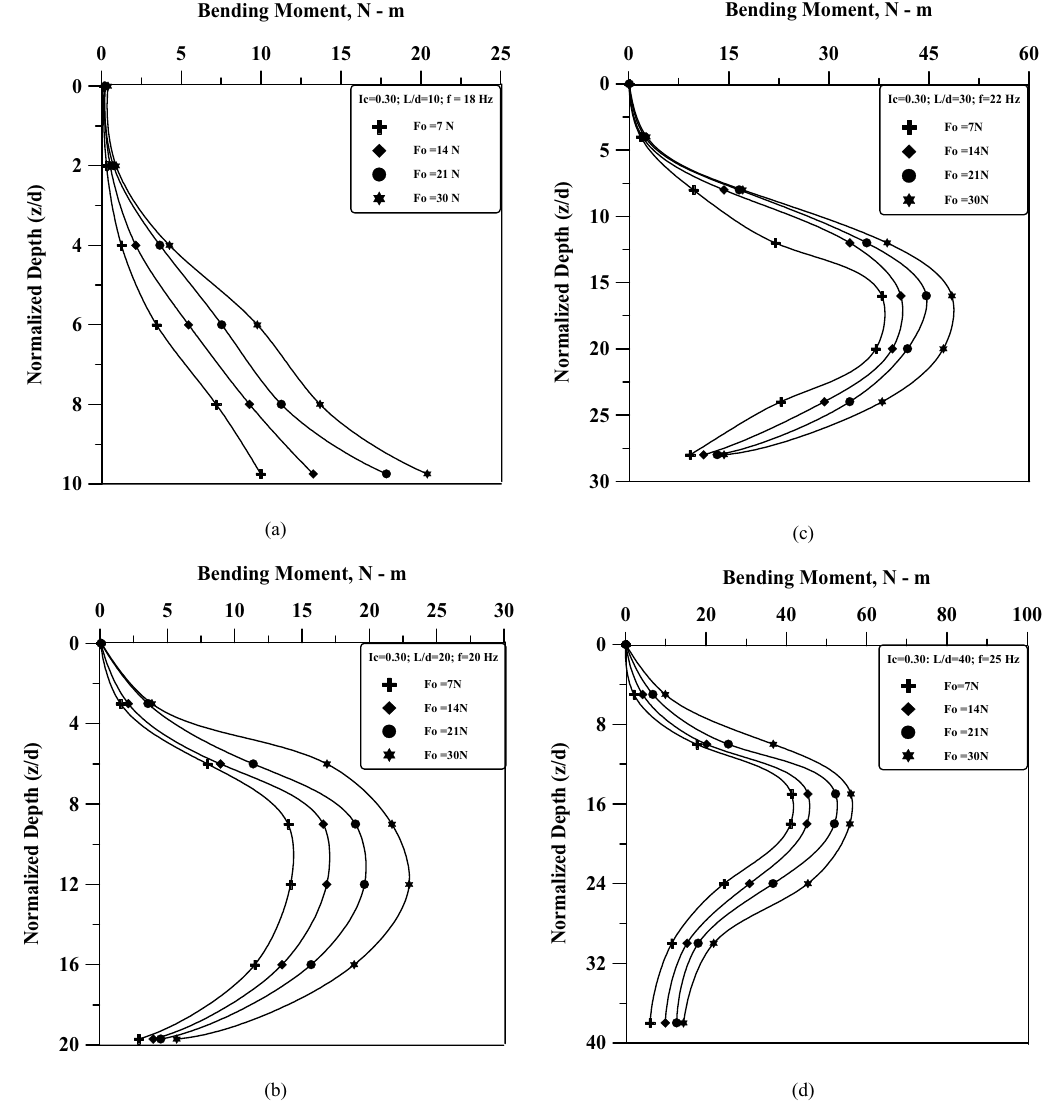
Fig. 14. Variation of dynamic bending moment of piles with normalized depth for I c = 0.30 (a) L/d = 10; (b) L/d = 20; (c) L/d = 30 (d) L/d =